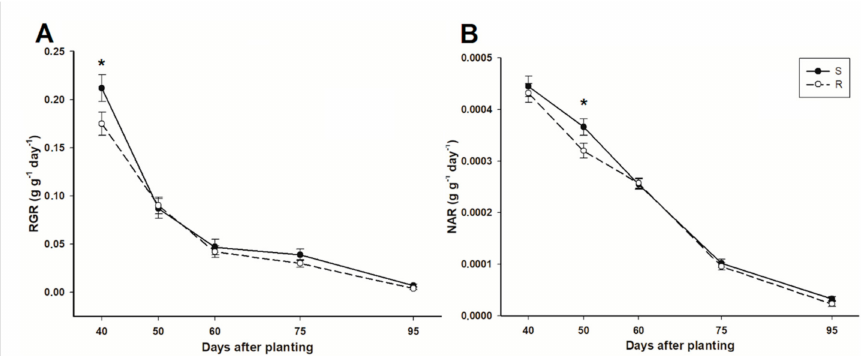
Figure 6. RGR—relative growth rate ( A ) and NAR—net assimilation rate ( B ) of imazamox-resistant (R) and susceptible (S) wild poinsettia plants. * indicates significant di ff erences at p < 0.05. Vertical bars ± standard error ( n =